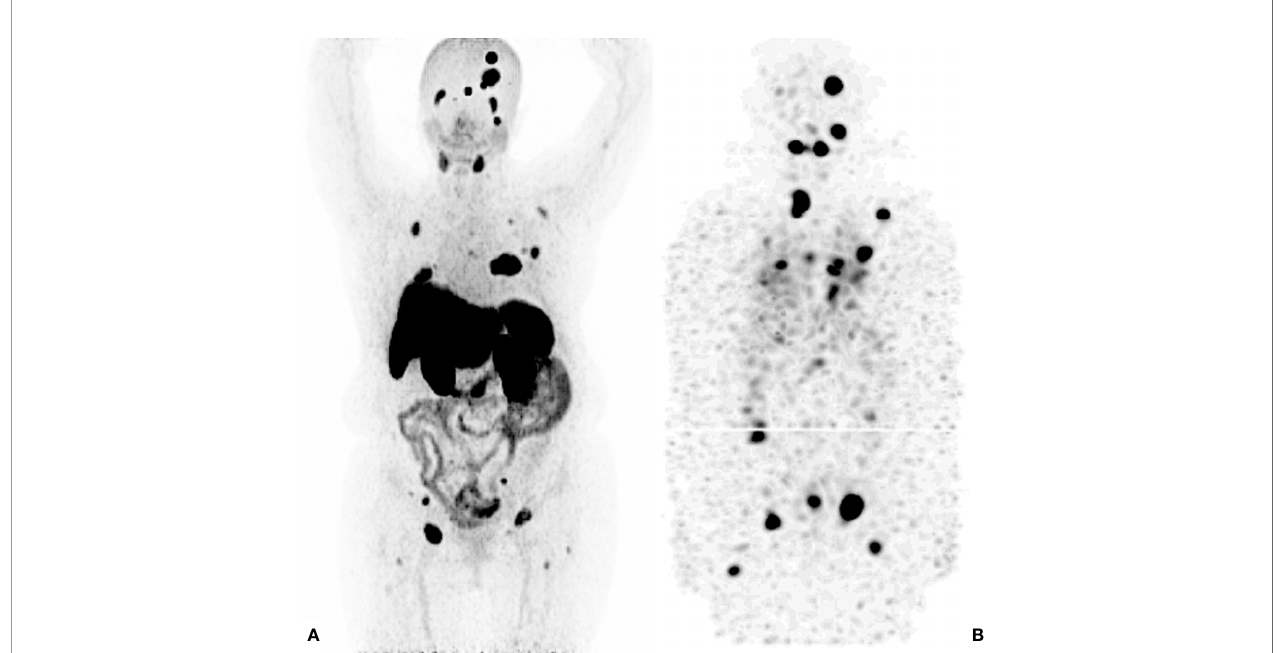
FIGURE 4 | 131 I – Post Therapy Whole Body Scan. 42 years old male, papillary thyroid carcinoma classic variant. Thyroglobulin 114. RAI cumulative dose (16650 MBq) Maximum Intensity Projections. (A) 68 Ga - PSMA PET/CT. (B) 131 I - SPECT/CT.